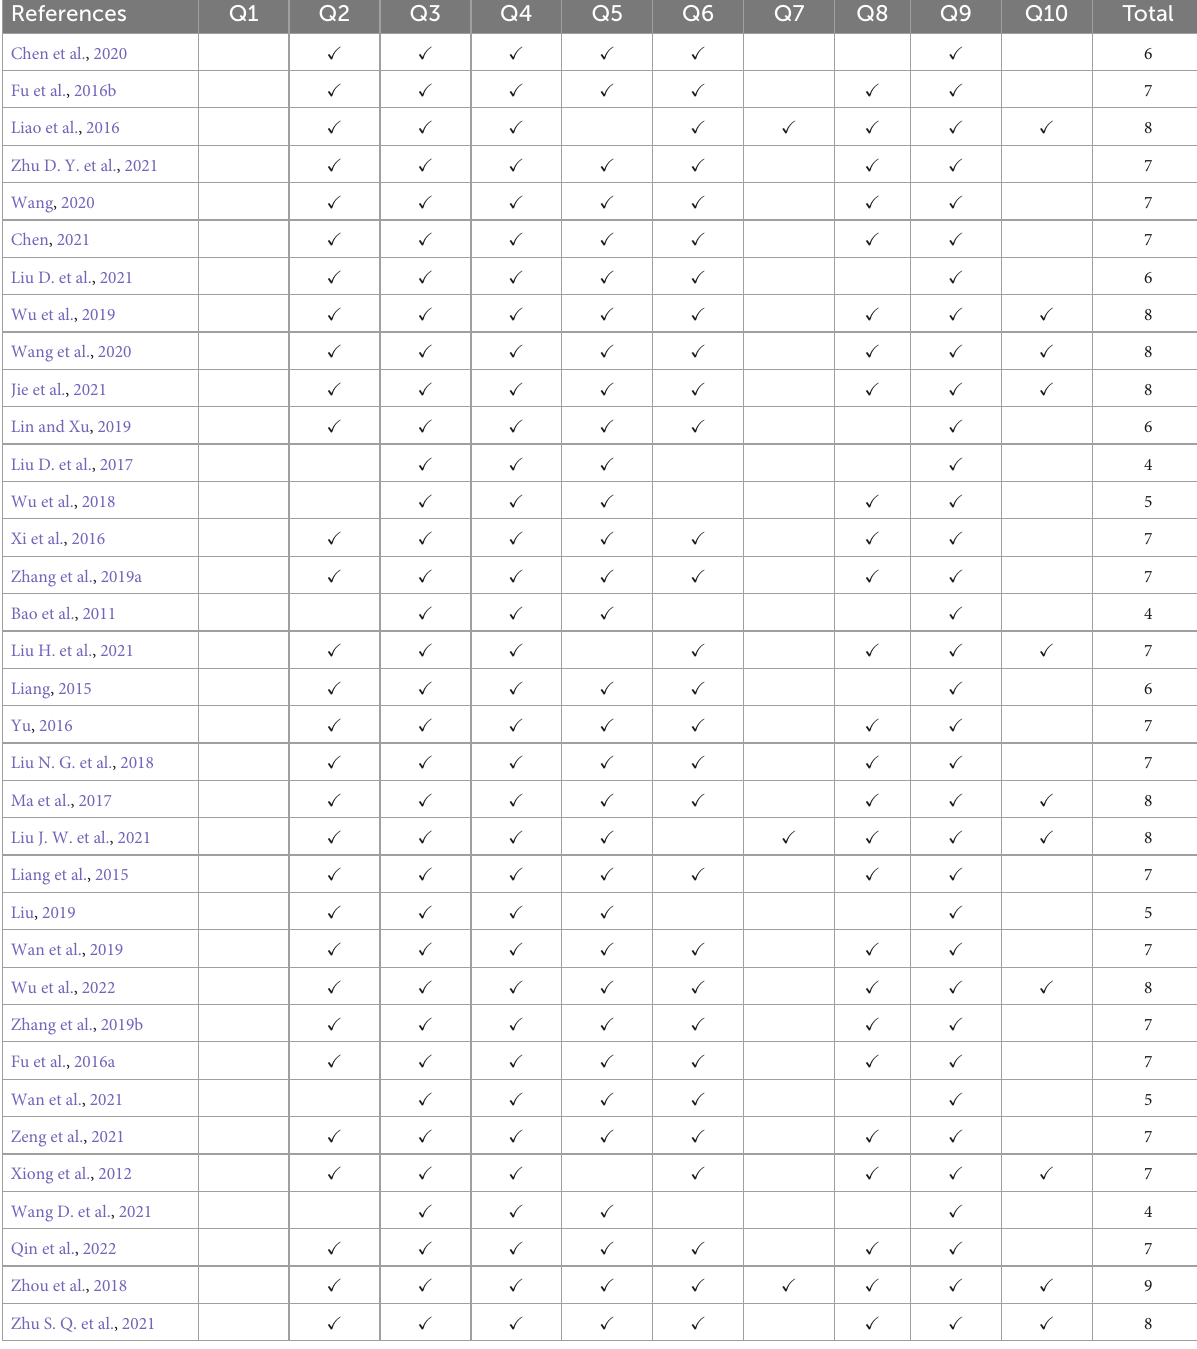
TABLE 1 Quality